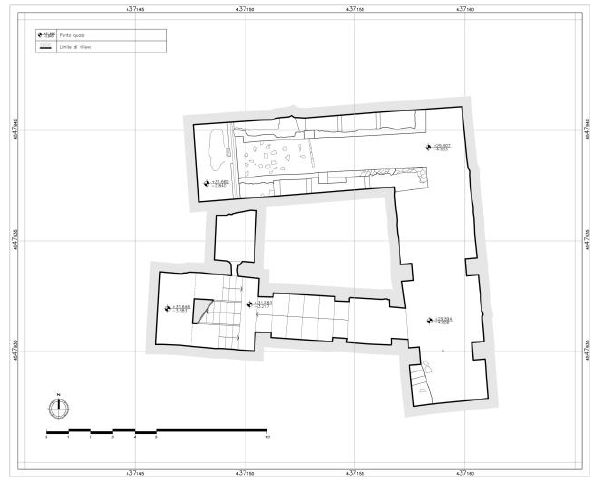
Figure 4. Graphic restitution of the plan of